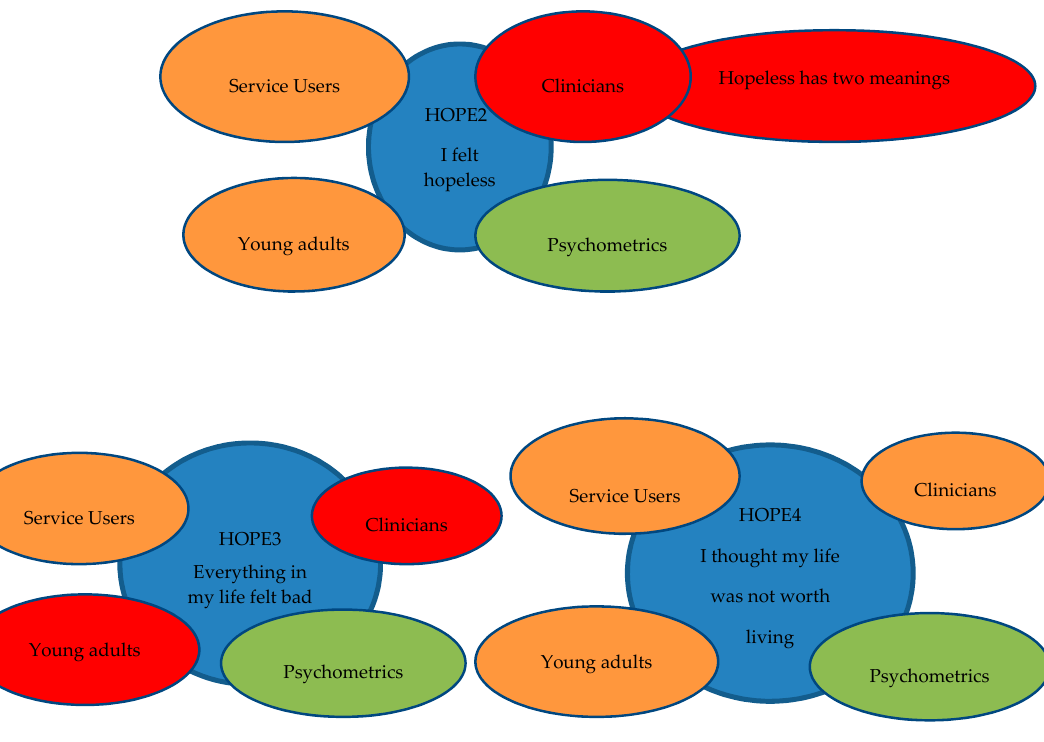
Figure 1. Combining qualitative with quantitative evidence (theme: hope; subtheme: hopelessness). blue: Item; green: Positive views/properties; orange: Mixed views/properties; red: Negative views/properties.